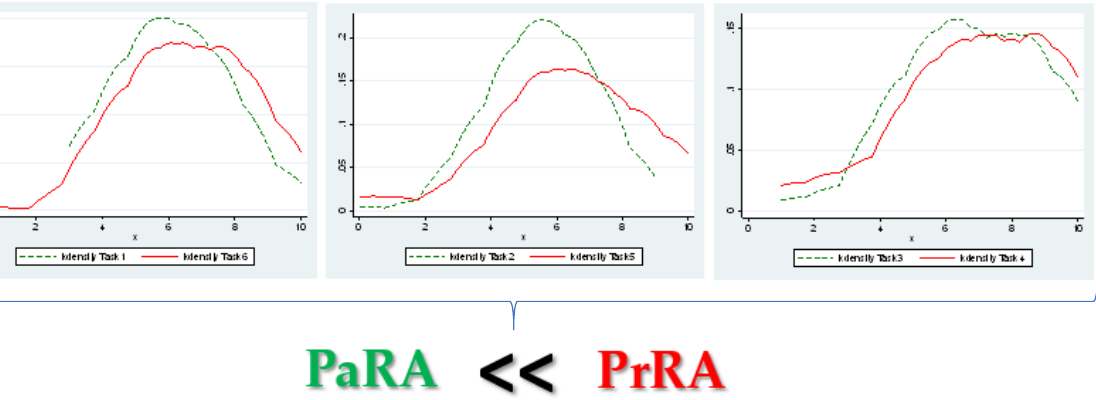
Figure 6. Kernel densities of the switching points and choice numbers selected by the subjects in corresponding designs. The dashes green lines represent the distributions of the degrees of PaRA and the solid red lines represent the degree of PrRA.